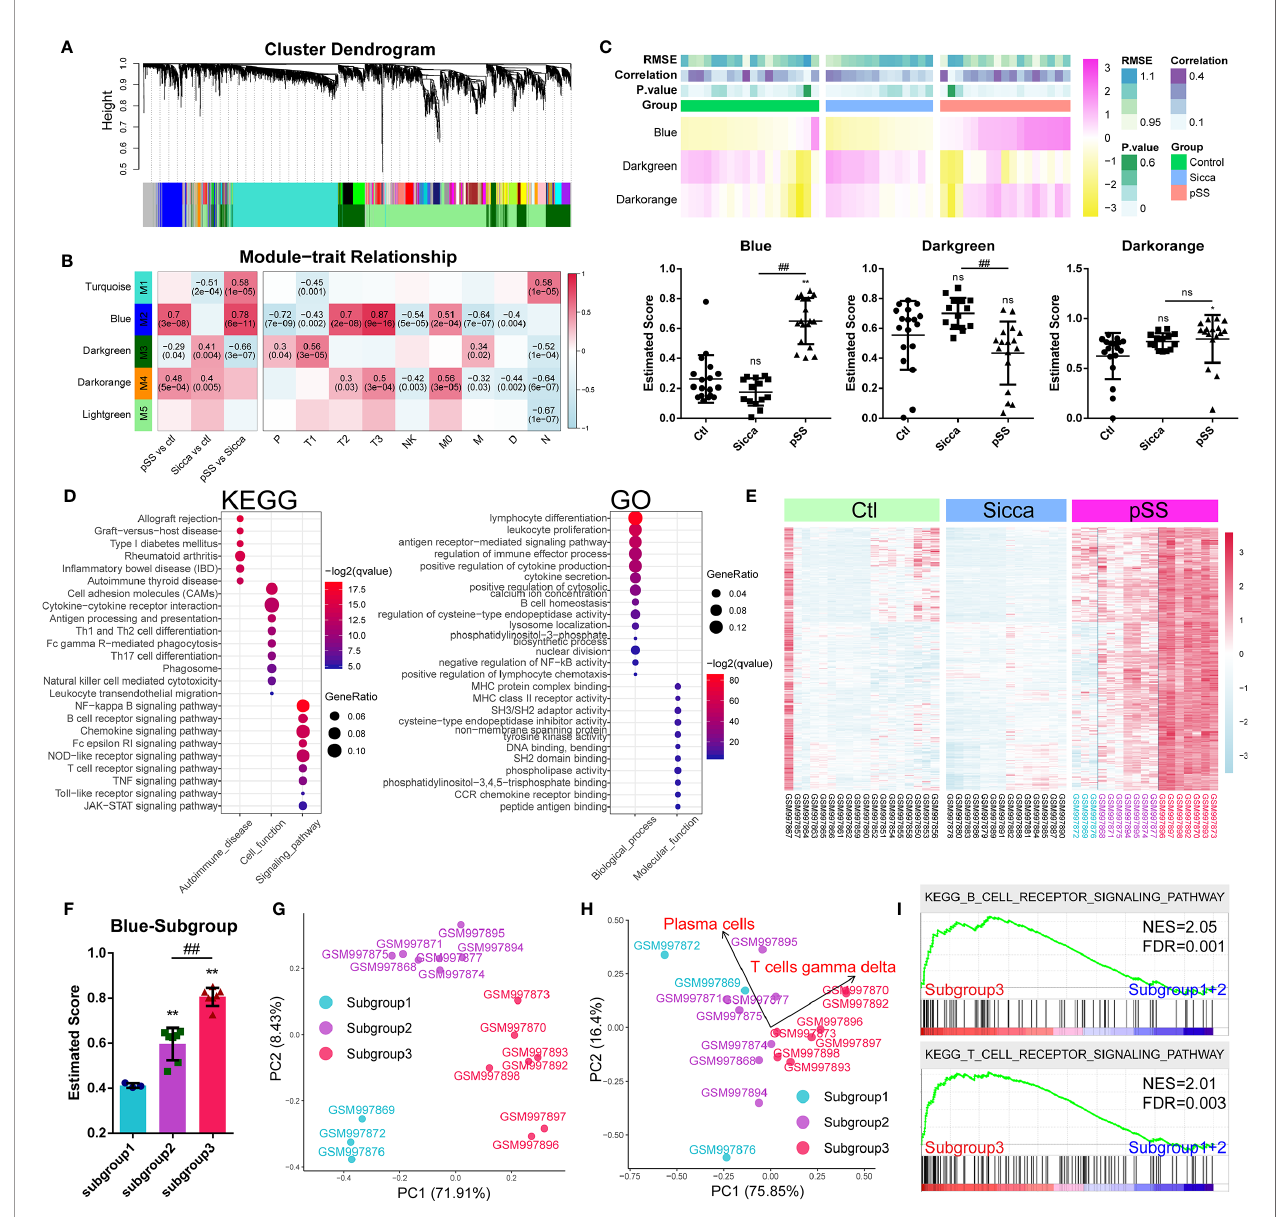
FIGURE 3 | Gene modules associated with pSS-speci fi c immune in fi ltration patterns. (A) Gene dendrogram calculated by average linkage hierarchical clustering. The color row underneath the dendrogram shows the assigned original module and the merged module. (B) Heatmap of the correlation between module eigengenes and disease or immune-in fi ltration features. The value in each square re fl ects the Pearson correlation coef fi cient, with the P value in parentheses. pSS vs ctl, comparison of pSS versus control; “ Sicca ” vs ctl, comparison of “ Sicca ” versus control; pSS vs “ Sicca ” , comparison of pSS versus “ Sicca ” . P, plasma cells; T1, CD8 T-cells; T2, memory activated CD4 T-cells; T3, gamma delta T-cells; NK, resting NK cells; M0, M0 macrophages; M, activated mast cells; D, resting dendritic cells; N, neutrophils. (C) Enriched score of the Blue, Darkgreen, and Darkorange immune-relevant modules in control, “ Sicca ” , and pSS samples estimated using the ssGSEA method. *P < 0.05, **P < 0.01, “ Sicca ” or pSS versus control; ##P < 0.01, pSS versus “ Sicca ” ; all P values were estimated using one-way ANOVA. (D) Functional annotation of the Blue module using GO and KEGG. (E) Heatmap of gene expression of the Blue module in the control, “ Sicca ” , and pSS samples. Three subgroups were identi fi ed (color blue, purple, and red). (F) Enriched score of the Blue modules of the three subgroups in pSS. **P < 0.01, “ Sicca ” or pSS versus control; ## P < 0.01, pSS versus “ Sicca ” ; P values were estimated using one-way ANOVA. (G) Principle component analysis (PCA) of the three subgroups of pSS samples based on the Blue module. (H) PCA of the three subgroups of pSS samples based on the disease-speci fi c in fi ltrated immune cells. Plasma cells and gamma T-cells were the robustly-contributing elements in PCA. (I) Gene Set Enrichment Analysis (GSEA) of the subgroups of pSS. NES, normalized enrichment score; FDR, false discovery rate, P values were estimated using one-way ANOVA and adjusted with the Benjamini – Hochberg method. ns, not signi fi